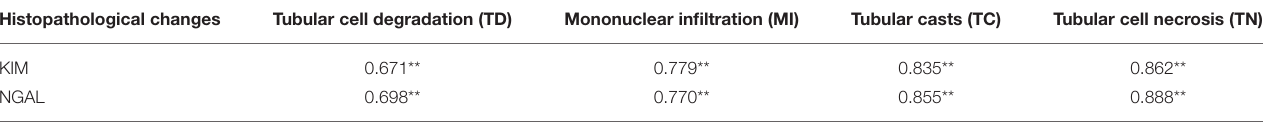
TABLE 3 | Pearson correlation ( r ) between renal histopathological findings and genetic expression of KIM-1 and NGAL in the study groups. Histopathological changes Tubular cell degradation (TD)